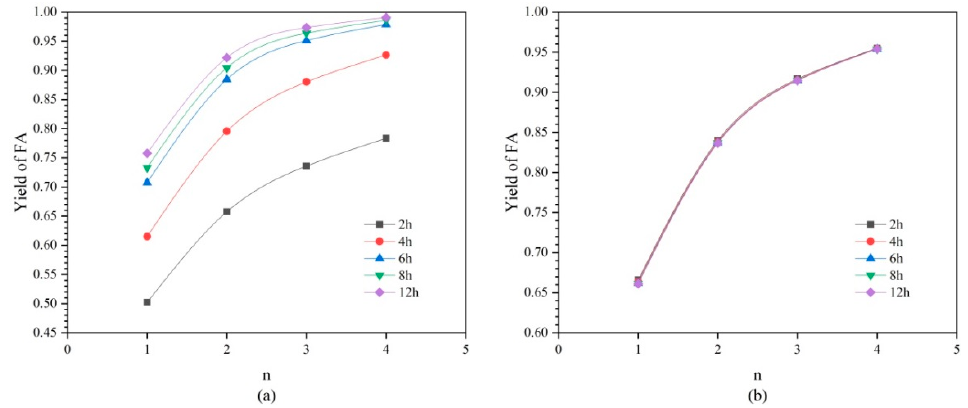
Figure 16. Influence of reaction time in single-stage reaction on yields of ( a ) LA and ( b ) FA.